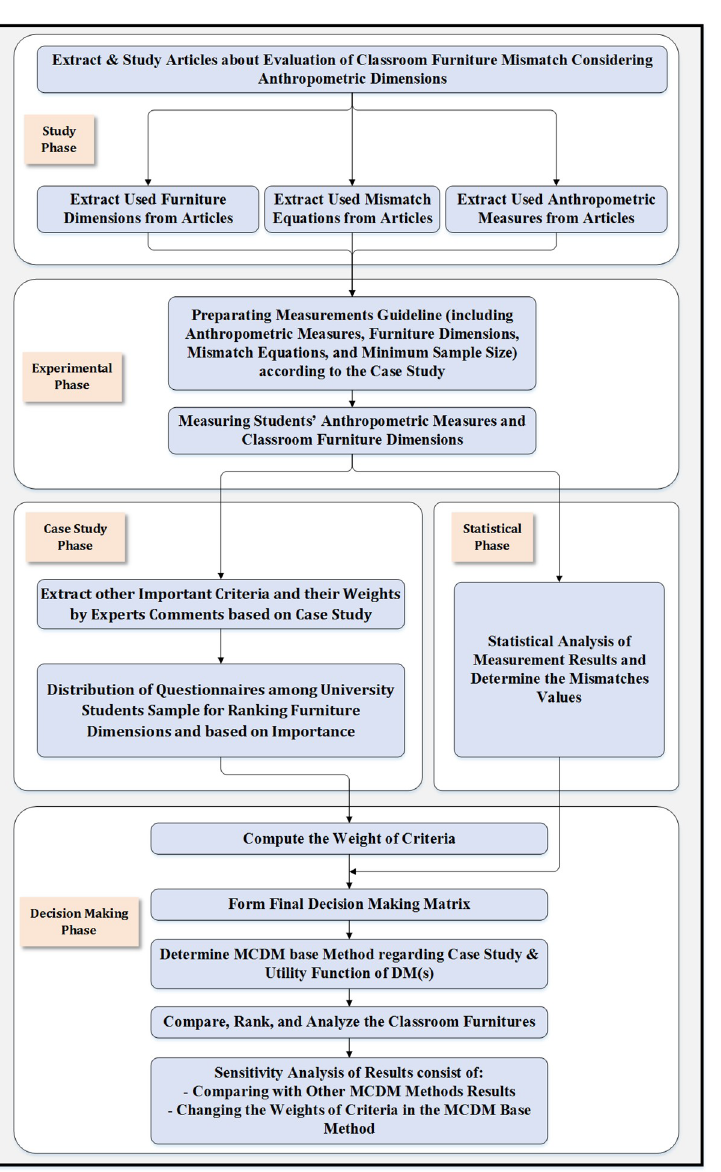
Fig 1. Study design